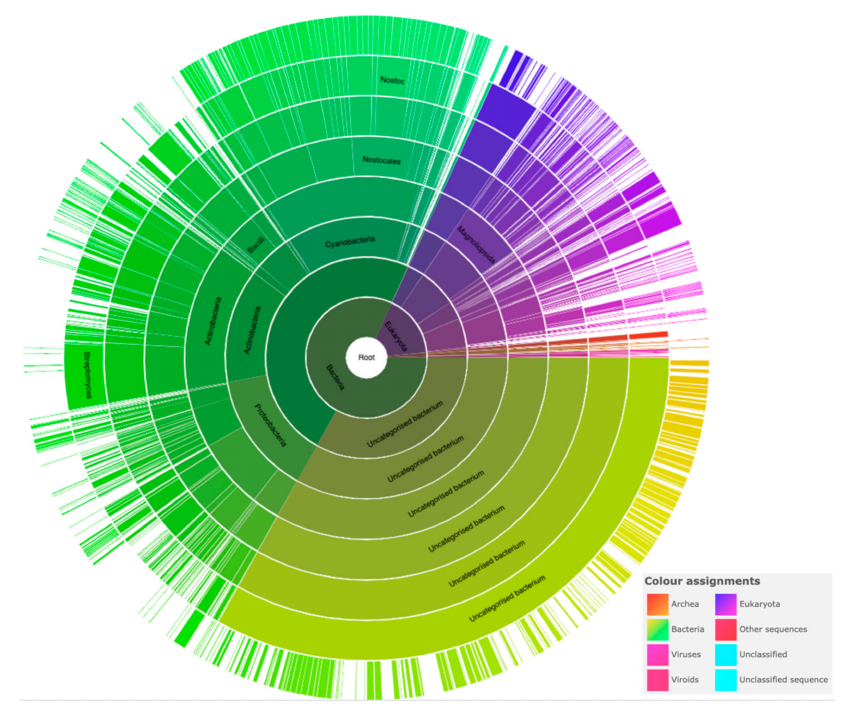
Figure 2. Distribution of PRP sequences across species. This sunburst plot of the PF00805 PRP Pfam shows the distribution of 38,981 sequences across 3338 species. The color-coding in the sunburst plot is indicated in the